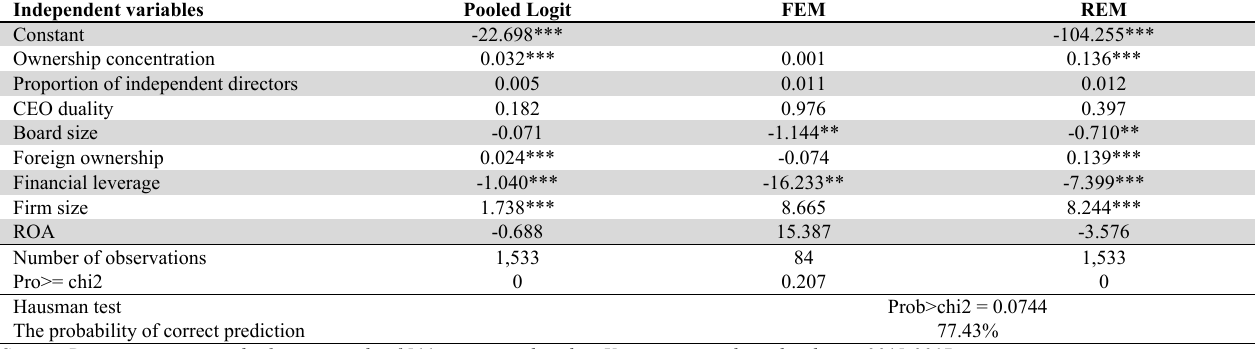
Estimated results of Pooled Logit, FEM and REM